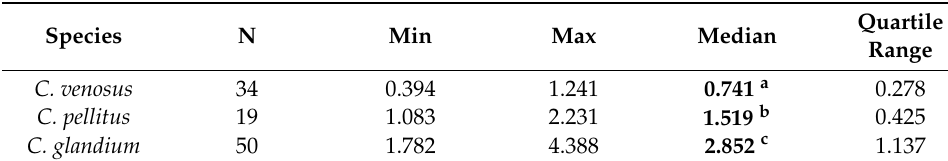
Table 1. Sample sizes of Curculio spp. females, minimal, maximal and median values, and quartile range of acorn masses (in grams) chosen by the particular species. Significant differences are marked with different letters. Bold fonts means the main variable upon which statistical evaluation is based.